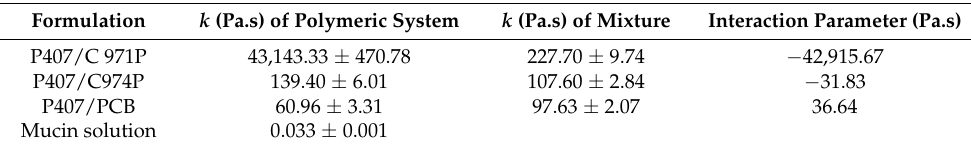
Table 4. Values of the consistency index ( k ) for polymeric blends containing poloxamer 407 (P407)